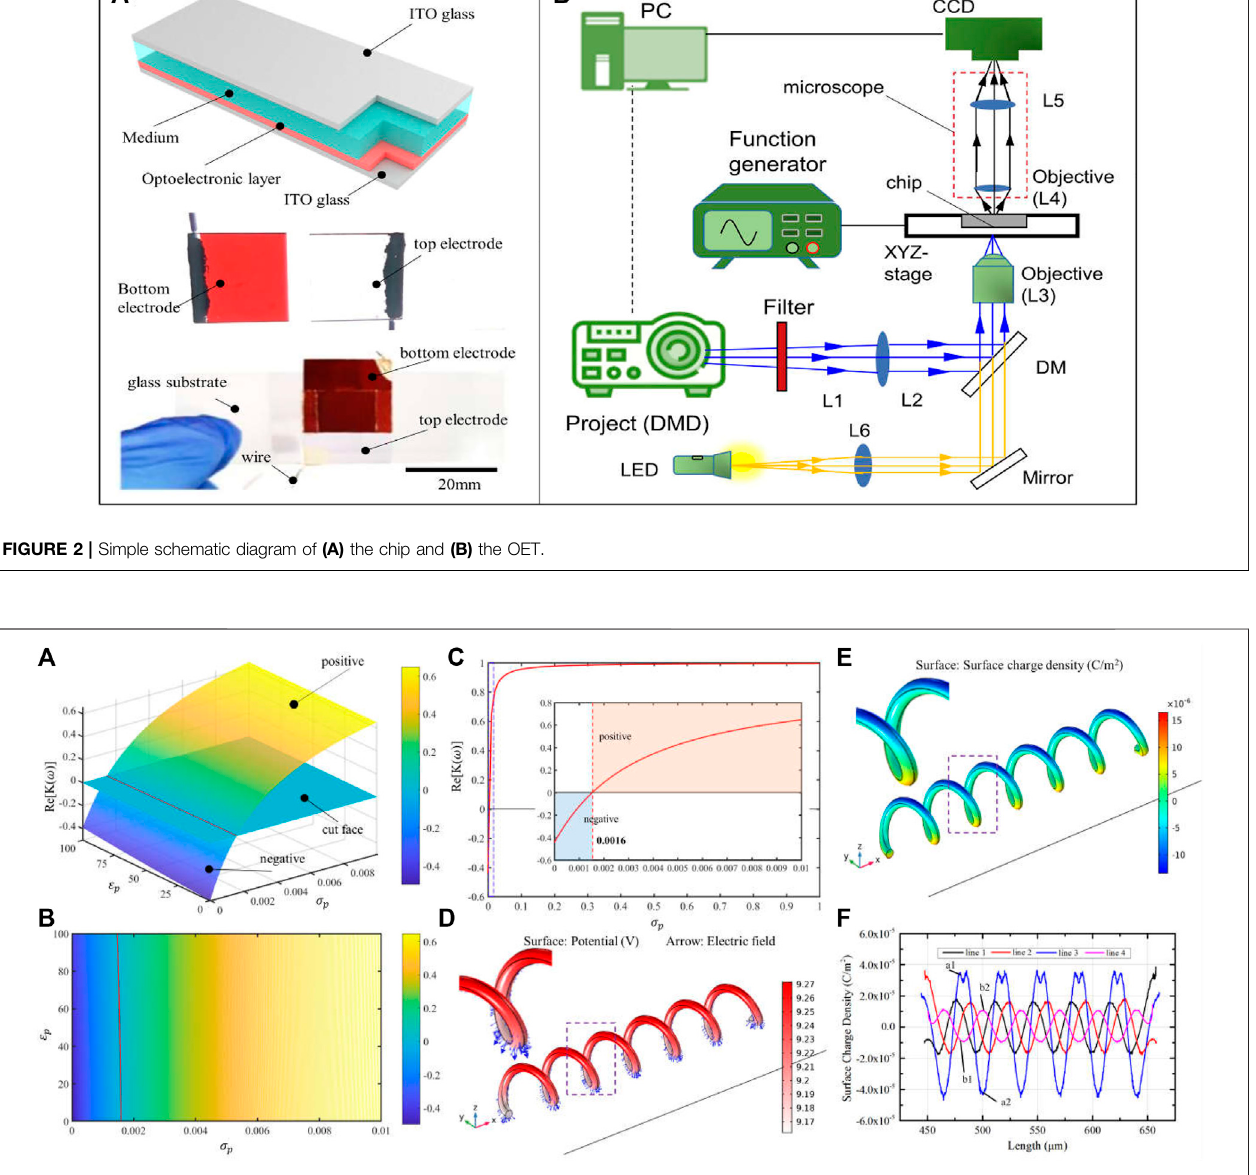
FIGURE3| Simulation parameters ofmicro- spirulina analysis. (A,B) Relationshipoftherealpart ofCMfactor- Re [ K ( ω )] andpermittivity andconductivityofmicro- spirulina. Blue plane is a cut-face. Redline is an intersecting line between cut-face and Re [ K ( ω )] values surface. When the Re [ K ( ω )] values surface is over the cut-face, the spirulina willsufferanattractedforce.Otherwise,itwillsufferarepelledforce. (C) Relationshipof Re [ K ( ω )] andconductivityofmicro- spirulina ,whenthepermittivityof micro- spirulina issetas58.52. (D) Electricpotentialandelectric fi elddistributionofmicro- spirulina inanOETsystem. (E,F) Surfacechargedensityofmicro- spirulina when it was polarized in the